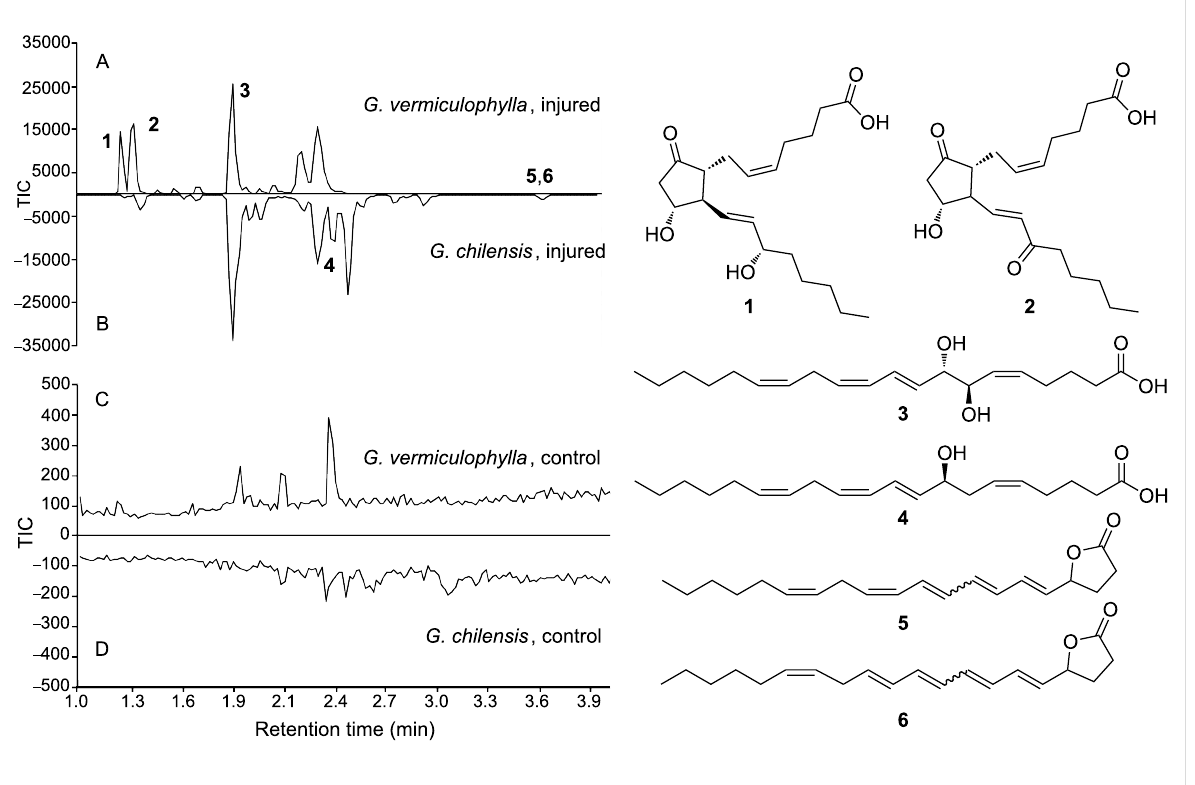
Figure 1: UPLC–ESIMS-based metabolic profiles of Gracilaria vermiculophylla (A) and Gracilaria chilensis (B) induced by grinding and incubation for 5 min at rt. In comparison, control runs with intact algal material that was boiled to prevent enzyme activity before extraction are given in (C) and (D). Total-ion-count (TIC) traces (ESI-negative mode) are shown; note: TIC normalized to 35000 counts in the wounded and to 500 counts in the chromatographic profiles of the control. The structures of the major metabolites are given, and the retention times of 5 and 6 are indicated; these metabolites do not show up in the ESI negative